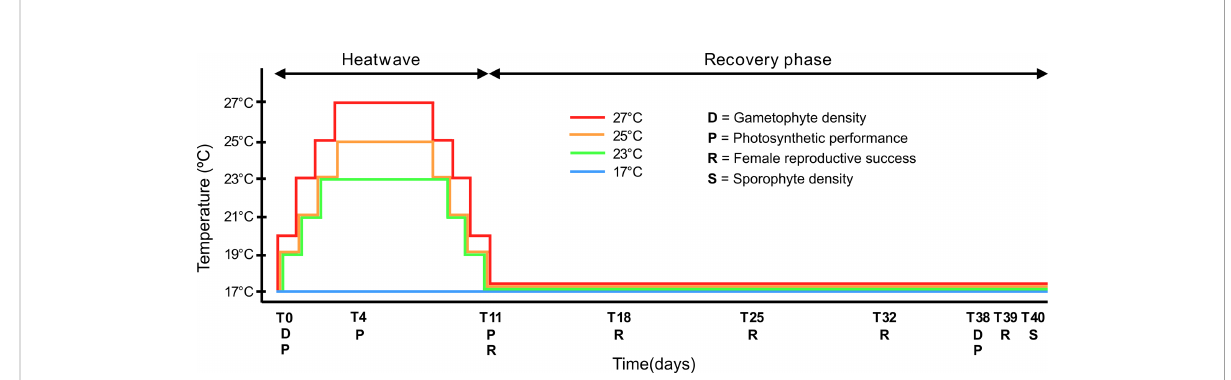
FIGURE 2 Design of the simulated MHW and recovery experiment. Laminaria ochroleuca gametophytes from four populations were exposed to different thermal treatments (17°C, 23°C, 25°C, 27°C) for 11 days and subsequently transferred to 17°C (recovery phase) for 29 days. Gametophyte density, photosynthetic performance, female reproductive success and sporophyte density were evaluated in different time